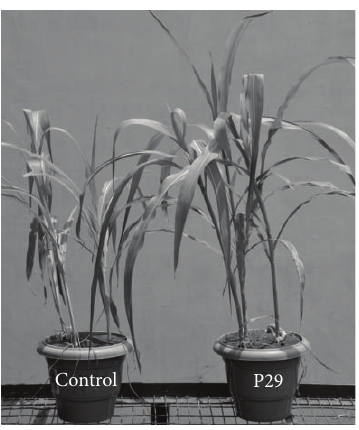
Figure 1: Plant growth promotion of maize with zinc solubilizing Pseudomonas sp. strain-P29 (60DAS).